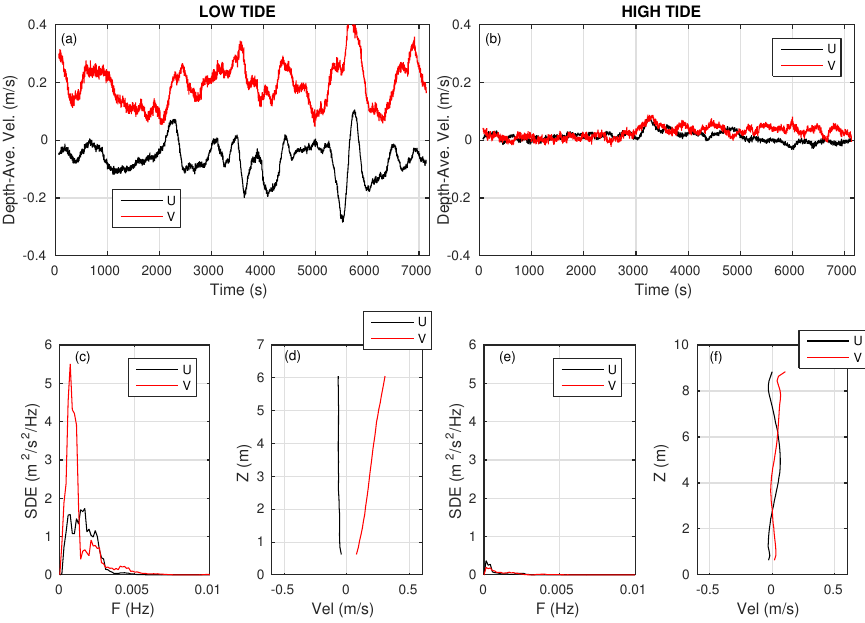
Figure 6. Moderate-energy deflection rip event on 23 October 2018 at low (left-hand panels) and high (right-hand panels) tide with cross-shore ( V > 0 for westward current) and alongshore ( U > 0 for northward current) depth-averaged velocity components in red and black, respectively. ( a , b ) 2-h burst of 2-min moving averaged velocities; ( c , e ) spectral density of energy; ( d , f ) burst-averaged velocity profiles.